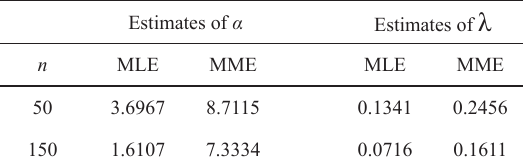
Average root mean squared error.